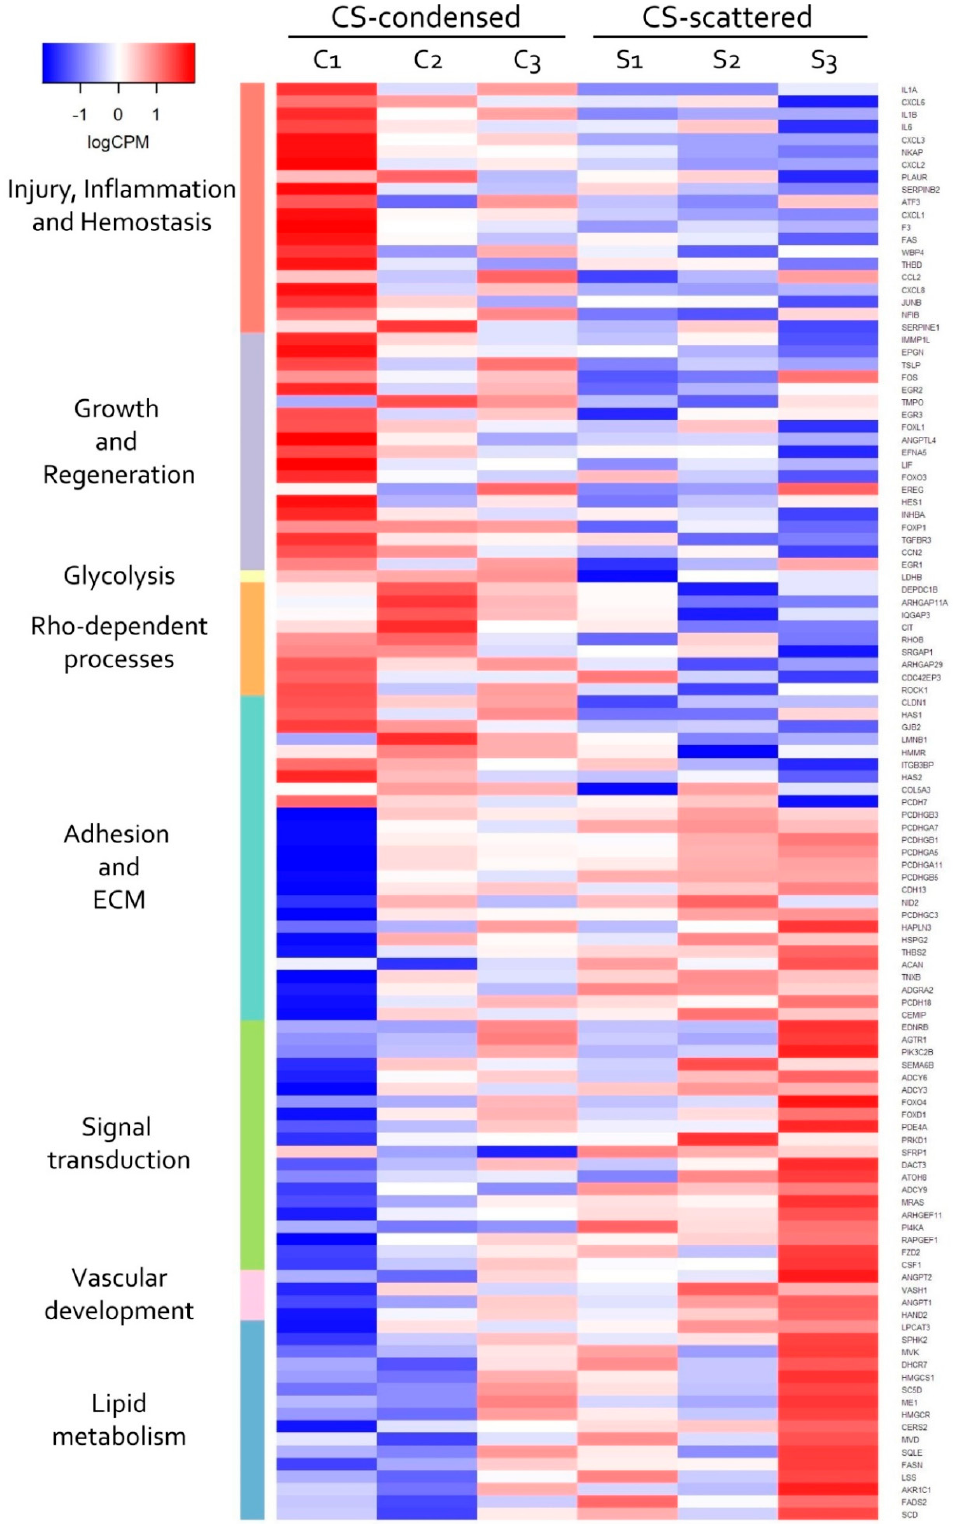
Figure 7. Heat map illustrating differential gene expression between the cells of CS-condensed and CS-scattered areas according to RNA-Seq. The expression values are normalized using CPM (count per million) measures. The columns represent samples, and rows represent upregulated (red) and downregulated (blue) genes. The samples are grouped by conditions and biological replicates. The left colored panel shows the association of the genes with some of the top GO terms. The displayed genes have been manually selected from all DEGs as those representative of the highlighted associated